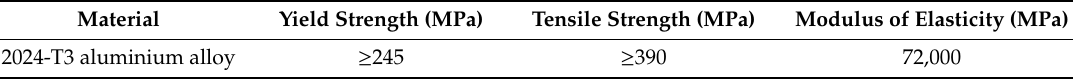
Table 2. Material parameters of the Al 2024-T3 aluminum alloy.